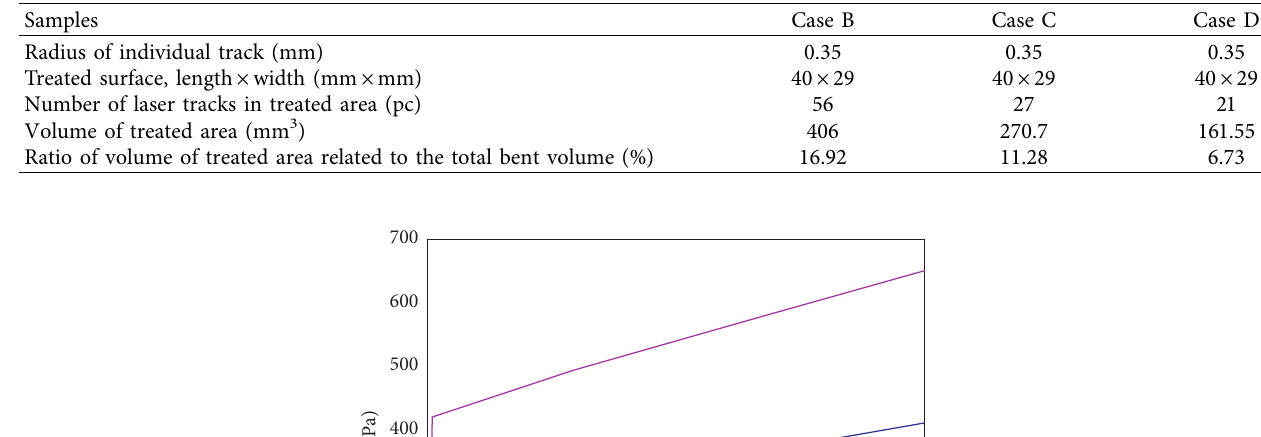
Table 6: The geometry of treated area.